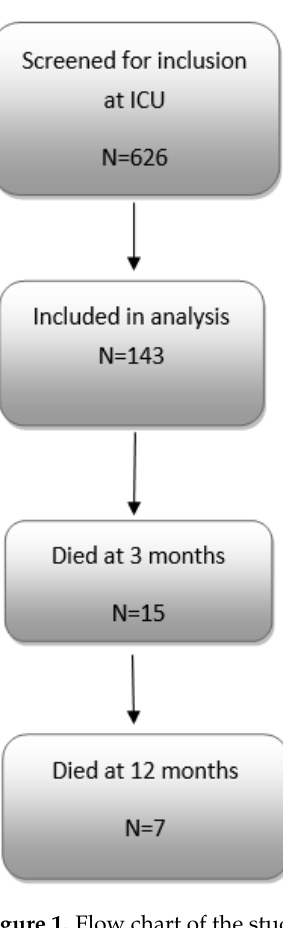
Figure 1. Flow chart of the study. Table 1. Social and demographic characteristics of participants.